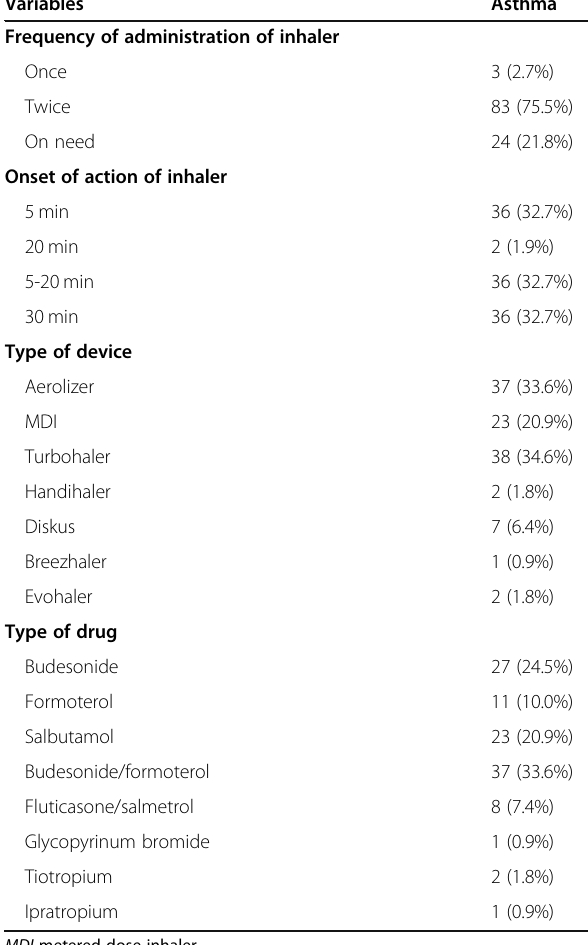
Table 1 Patients with asthma according to medications